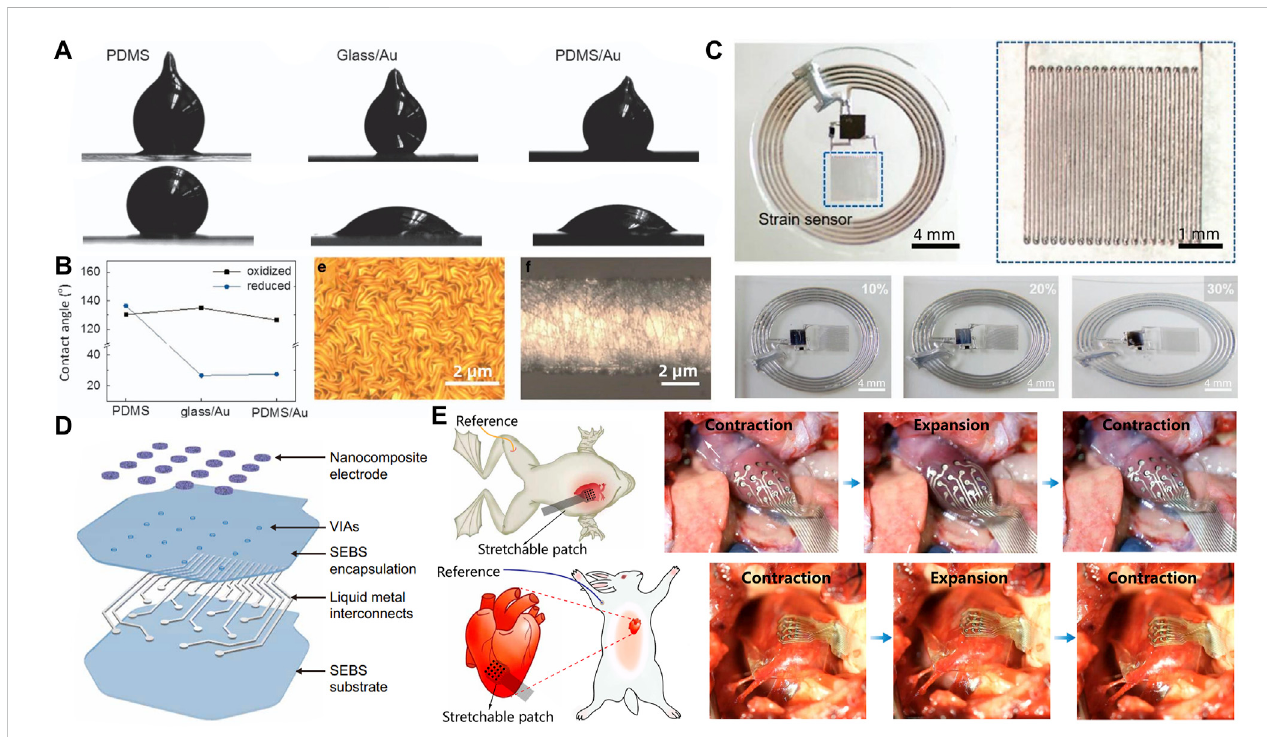
Printing method based on metal welding. (A) Contact angle images of the GaInSn droplet on various substrates of PDMS, Au deposited glass substrate and Au deposited PDMS substrate (Jeong et al., 2017). Copyright@2017, Springer nature (B) Contact angle measurement of oxidized and reduced GaInSn on various substrates and optical images of Cr/Au fi lm and liquid-metal pattern (Jeong et al., 2017). Copyright@2017, Springer nature (C) Optical images of the device under uniaxial strain up to 30% (Jeong et al., 2017). Copyright@2017, Springer nature (D) The layer-by-layer construction of the electronic patch (Wang et al., 2022e). Copyright@2022, AAAS (E) Schematic illustration of the experimental setup for epicardial electrogram acquisition from a living bullfrog and rabbit (Wang et al., 2022e). Copyright@2022,